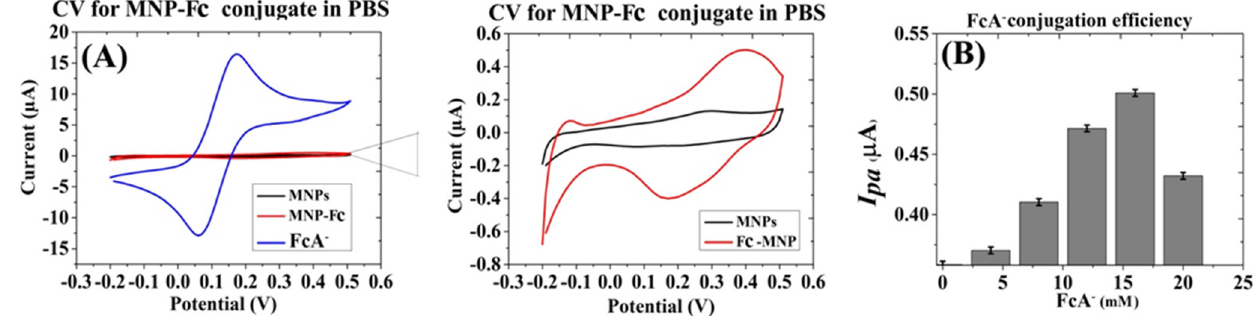
Figure 2. Preparation of ferrocene-conjugated MNPs. ( A ) CV of MNPs and Fc-MNP from the optimized concentration of FcA- (16 mM) in 1 × PBS. ( B ) Conjugation with different concentrations of FcA- affects the measured anodic current peak. Measurements were performed in triplicates. Error bars represent the standard deviation of means for triplicate.